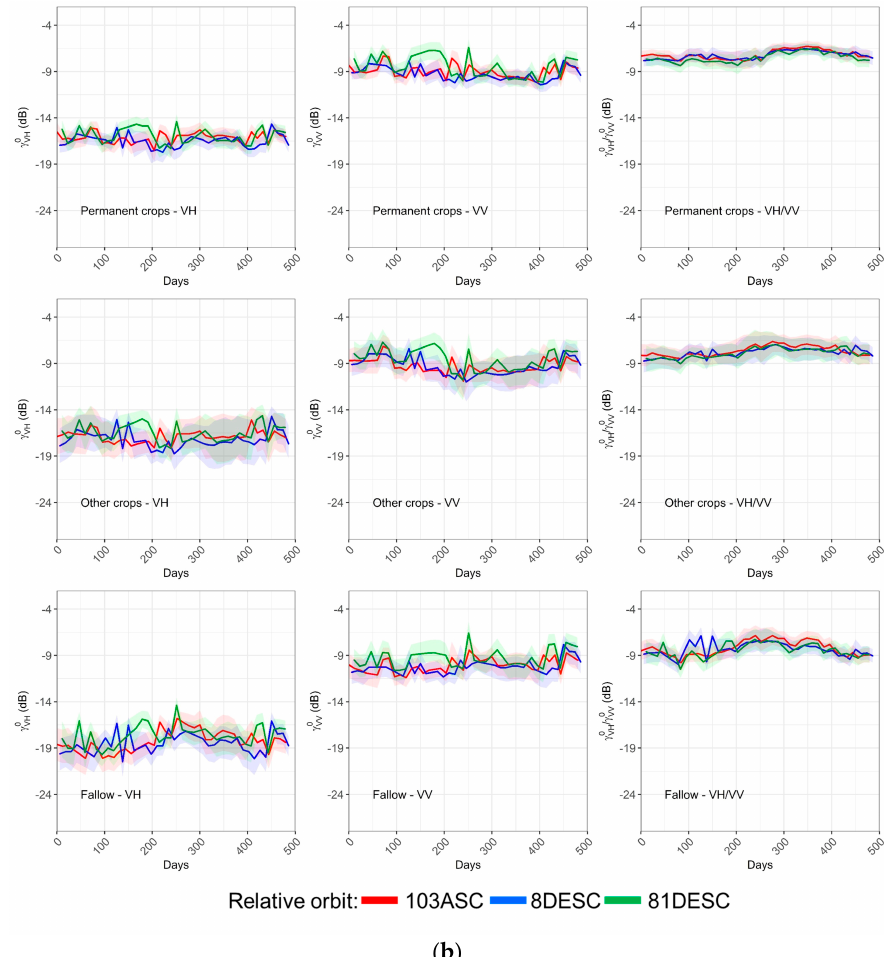
Figure 8. ( a ) Median temporal signatures of alfalfa, asparagus and grasslands for VH, VV and VH/VV in Navarre. The three relative orbits are represented in different colors (see the legend). The interquartile range is represented for all the different time series as a colored shadow. The horizontal axes represent the period of study, from 1 September 2015 (day 0) to 30 December 2016 (day 487); ( b ) Median temporal signatures of permanent crops, other crops and fallow for VH, VV and VH/VV in Navarre. The three relative orbits are represented in different colors (see the legend). The interquartile range is represented for all the different time series as a colored shadow. The horizontal axes represent the period of study, from 1 September 2015 (day 0) to 30 December 2016 (day 487).